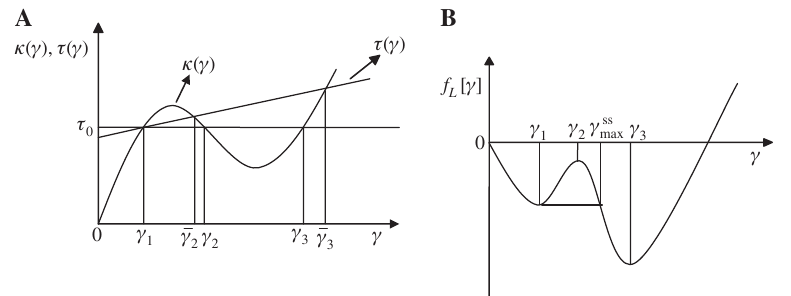
Figure 1 (A) Double-loop constitutive relation for κ ( γ ) and stress τ ( γ ) for the dynamic case. (B) Double-well local free energy density [ γ functional f L